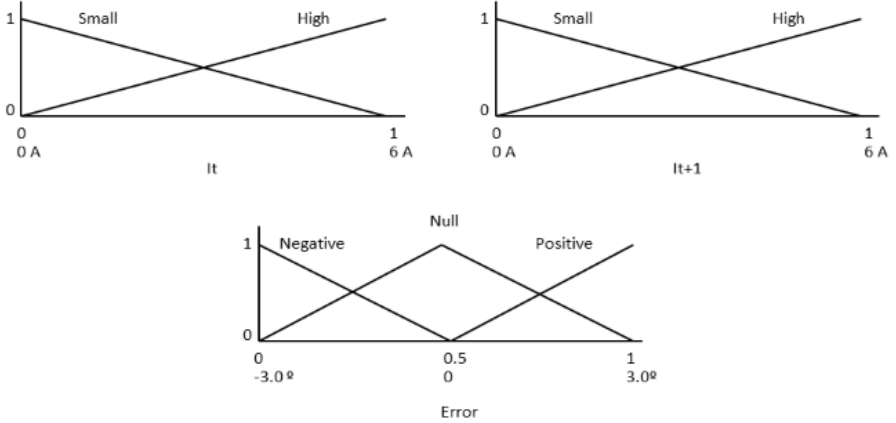
Figure 6. Fuzzy sets defined in input (It and I t + 1 ) and output variables (error).